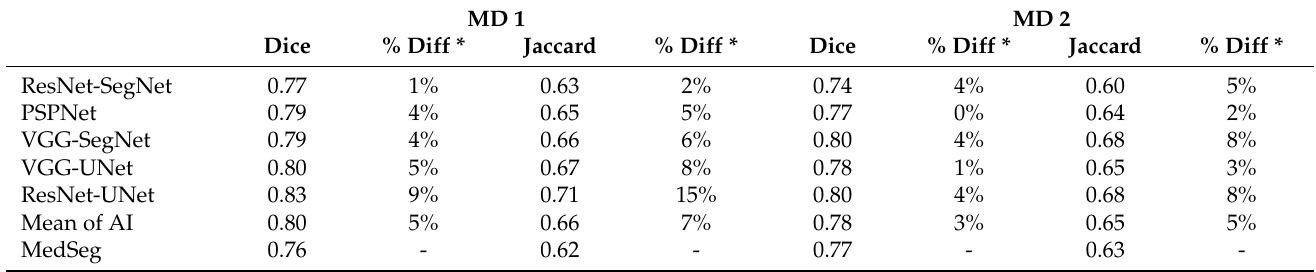
models (ResNet ‐ SegNet, PSPNet, VGG ‐ SegNet, VGG ‐ UNet, and ResNet ‐ UNet) are all bet ‐